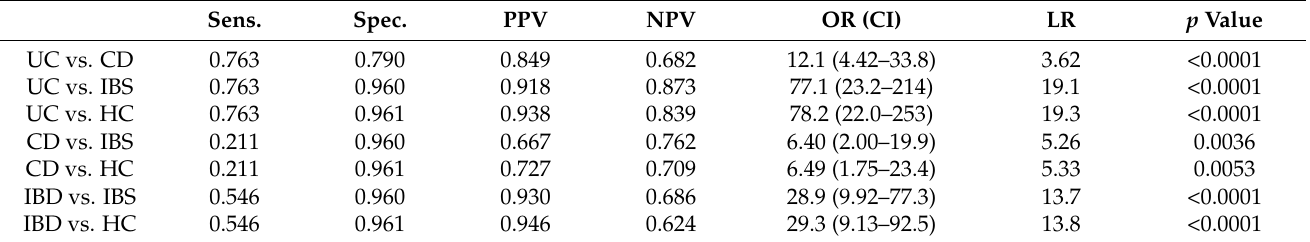
Table 2. Diagnostic performance of serum IgG anti-integrin α v β 6 autoantibodies in patients with UC and CD.